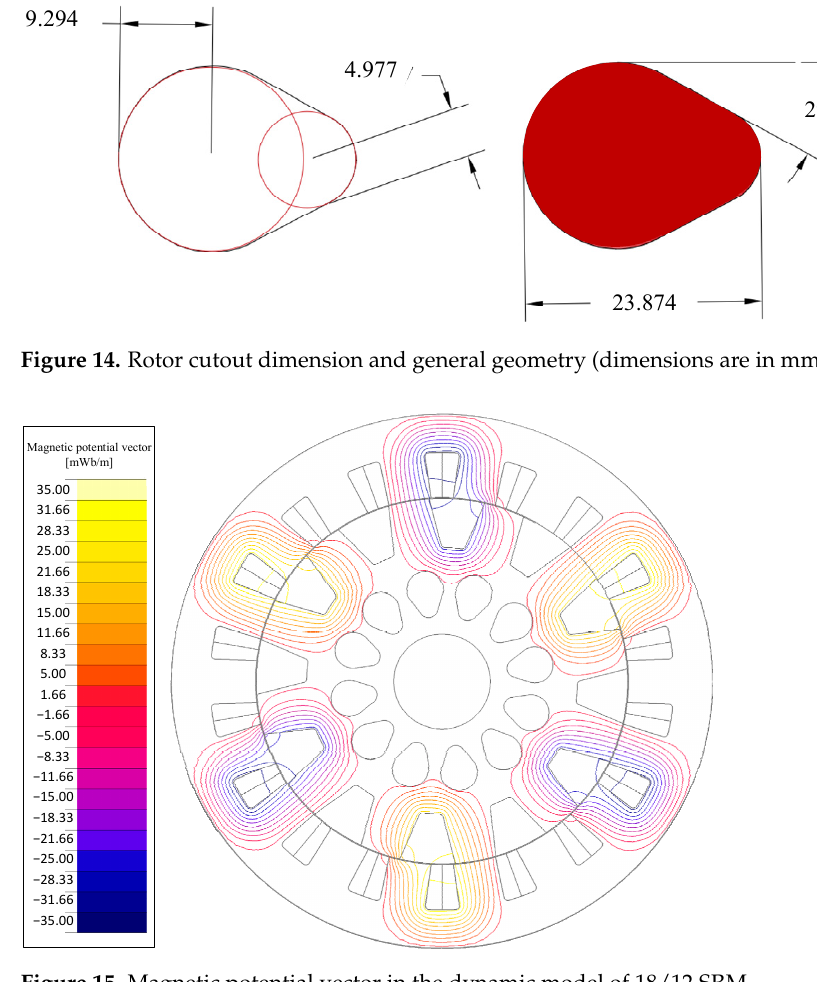
Figure 15. Magnetic potential vector in the dynamic model of 18/12 SRM.